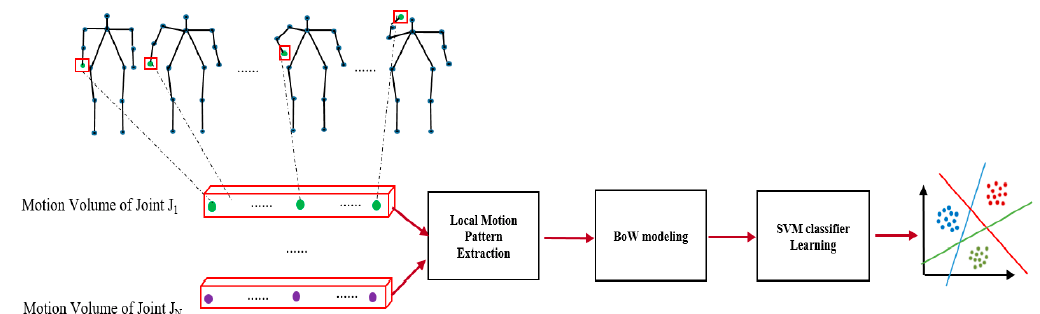
Figure 3. The pipeline of the action classification component. (The input of the action classification